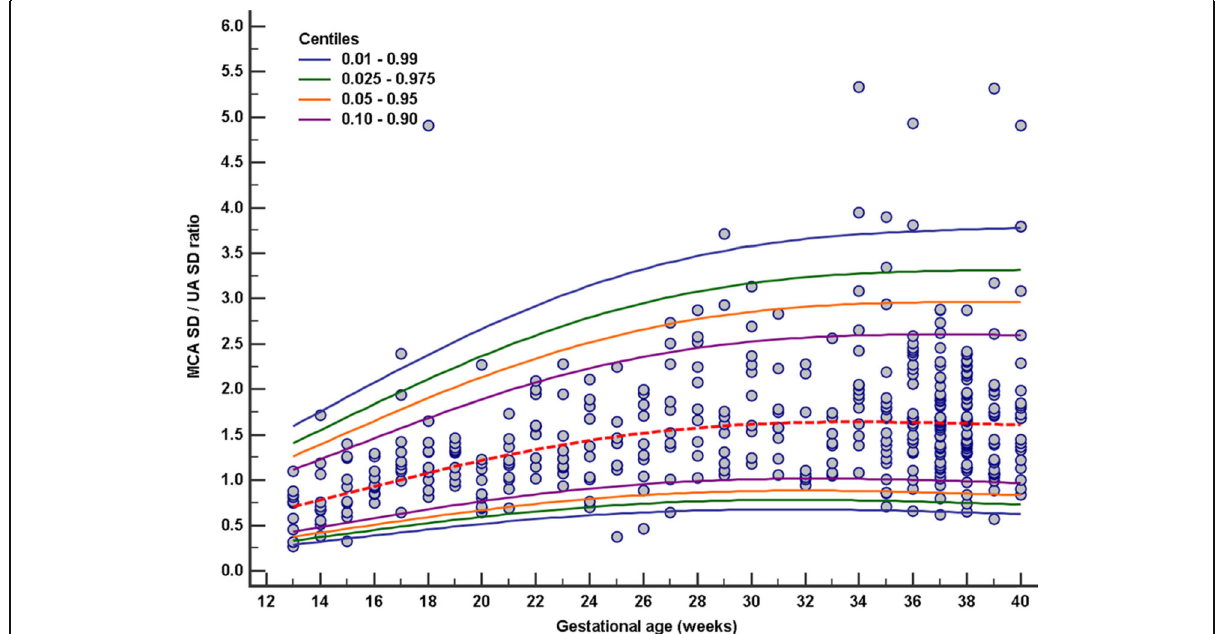
Fig. 2 S/D ratio MCA/UA. Scattered diagram of gestational age individual measurement and calculated reference ranges for MCA S/D ratio to UA S/D ratio in normal pregnancies (1284 observations) with 1st – 99th percentiles (blue lines) and 50th percentiles (red dashed